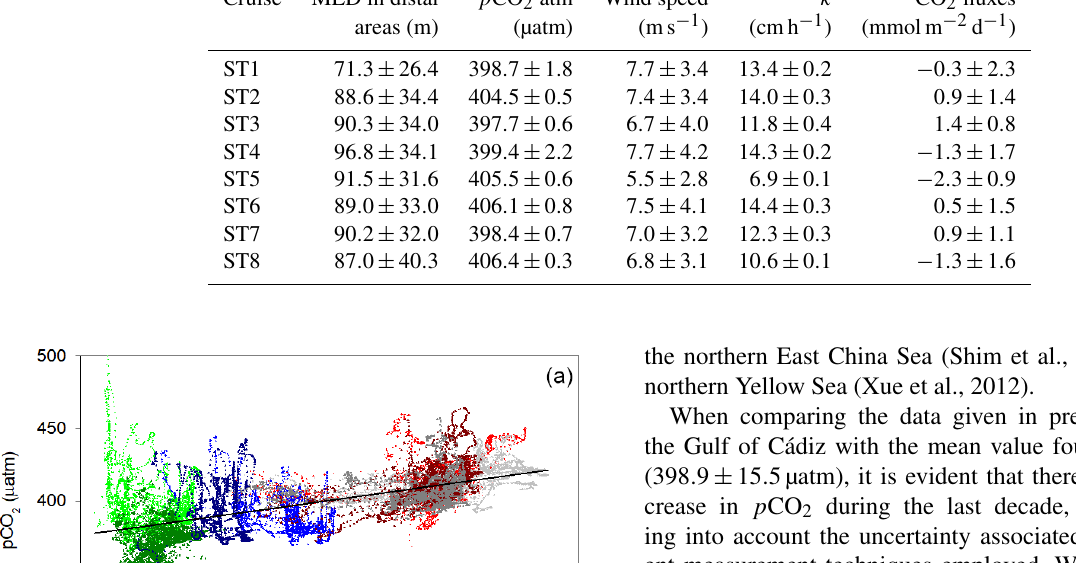
Table 3. Mean values and standard deviations of mixed layer depth (MLD) in distal areas (depth>50m), atmospheric p CO 2 ( p CO 2 µatm), wind speed, gas transfer velocity ( k ) and air–sea CO 2 fluxes for the underway measurements during the eight cruises: March 2014 (ST1), June 2014 (ST2), October 2014 (ST3), December 2014 (ST4), March 2015 (ST5), June 2015 (ST6), September 2015 (ST7) and Febru- ary 2016 (ST8). Cruise MLD in distal p CO 2 atm